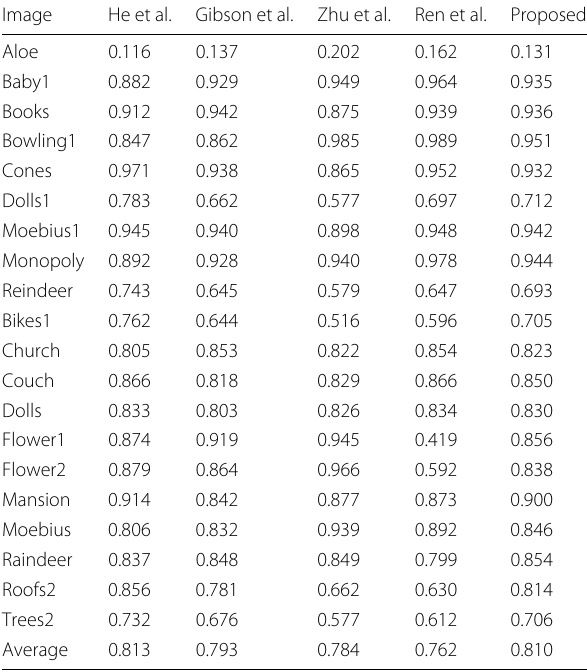
Table 4 Comparative analysis of time processing